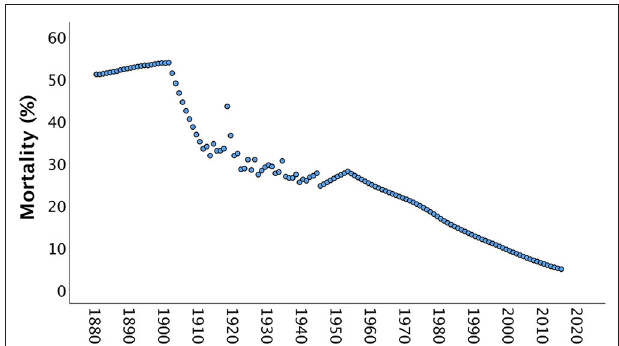
FIGURE 2 | Mortality rates of children aged below 5 years in India between 1880 and 2015. Until the early 20th century, over half of all children born died, and it was only from the 1960s onwards that mortality rates dropped below 1 in 3 children. Data from https://www.gapminder.org/data/documentation/ gd005/ (accessed April 24,